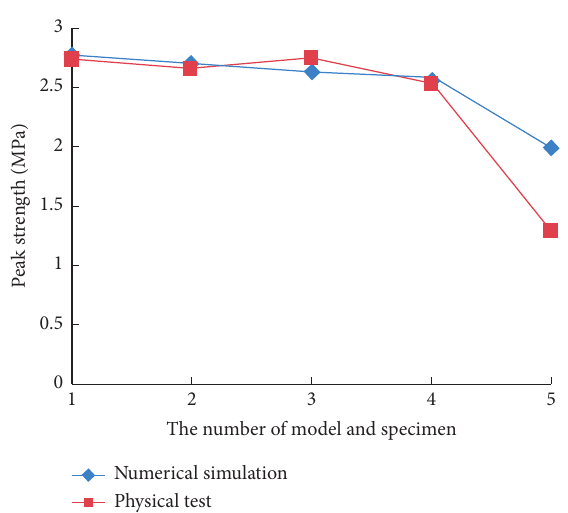
Figure 9: The comparison of physical test and stress peak value values of numerical simulation of five models.